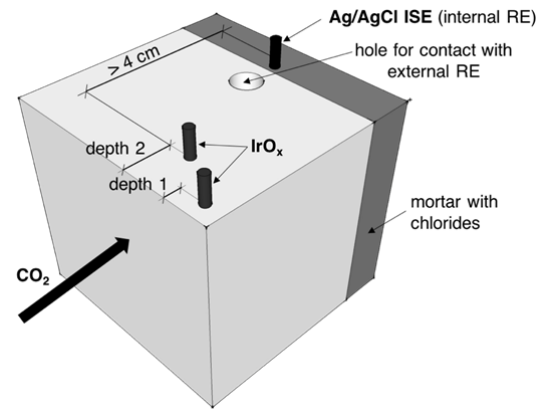
Figure 2. Illustration of the mortar samples used to monitor carbonation propagation with embedded IrO x sensors. All the surfaces were coated with epoxy resin with the exception of the ingress. Each sample contained 2 IrO x sensors at surface of CO 2 different depths. A chloride containing layer of mortar with an embedded Ag/AgCl electrode was used to provide an embedded reference electrode (see text for